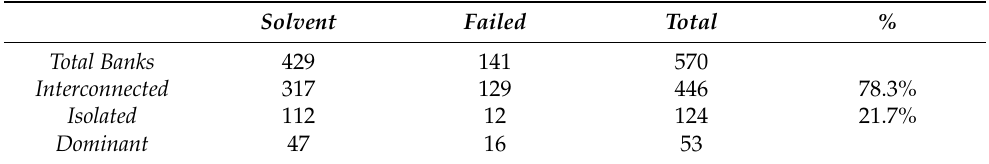
Table 1. Composition of the 570 banks network using the variable Tier 1/total asset. Threshold level =